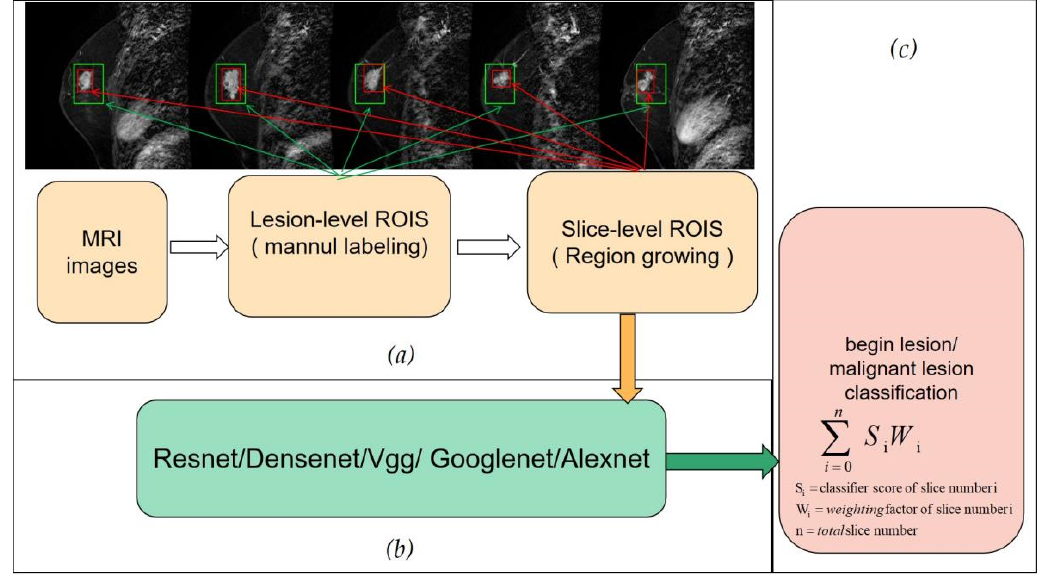
Figure 1. System architecture: ( a ) the extraction of the ROI as the input data of the DCNNs, the green box was the lesion-level ROI, and the red box was the slice-level ROI; ( b ) the DCNNs evaluated in this study including standard ResNet50, DenseNet, VGG16, GoogLeNet, and AlexNet for slice-level training and prediction; ( c ) lesion-level diagnosis layer.